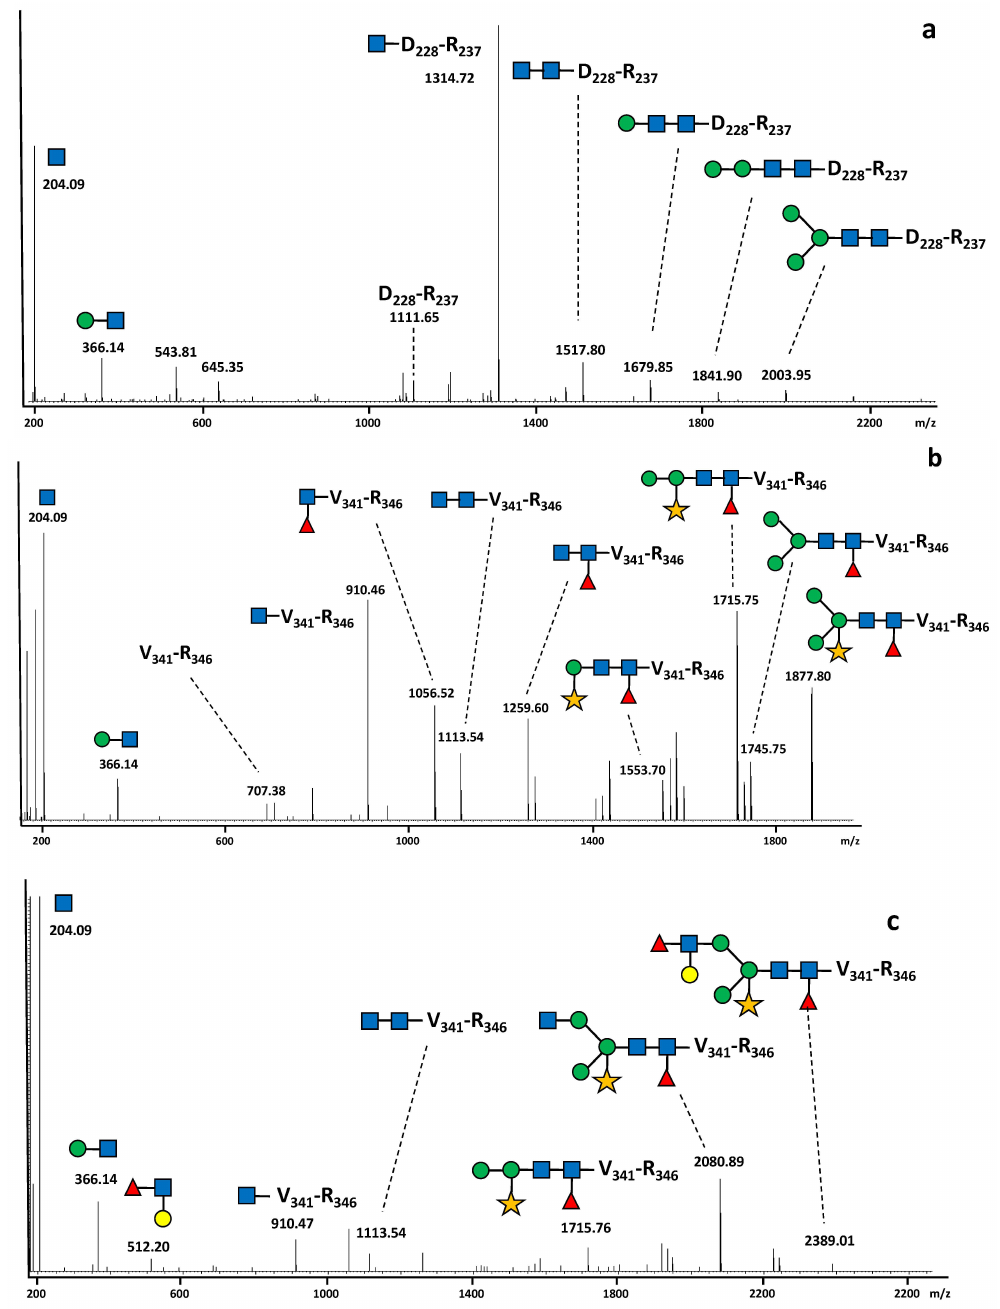
Figure 3. MS/MS spectra of ( a ) dicharged ion at m / z 1327.09 assigned to the peptide D 228 -R 237 N -linked to Man-7, ( b ) dicharged ion at m / z 1041.44 assigned to the peptide V 341 -R 346 N -linked to GnMXF and ( c ) dicharged ion at m / z 1296.54 assigned to the peptide V 341 -R 346 N -linked to Le a GnXF. Structures of fragment ions are depicted. Each N- glycan has been drawn according to the international nomenclature [22]. Blue square: GlcNAc; green circle: Man; red triangle: Fuc; yellow circle: Gal and yellow star: